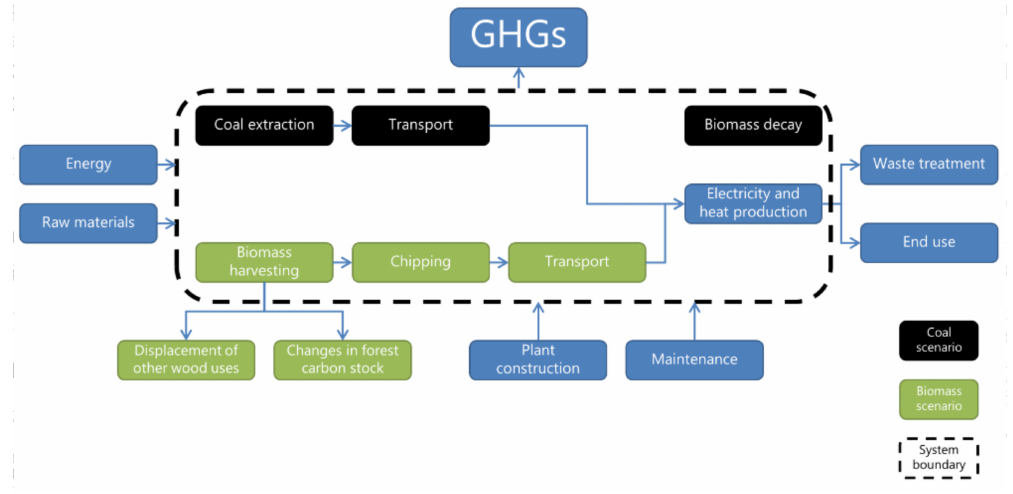
Figure 1. Overview of system boundaries and system components included in this